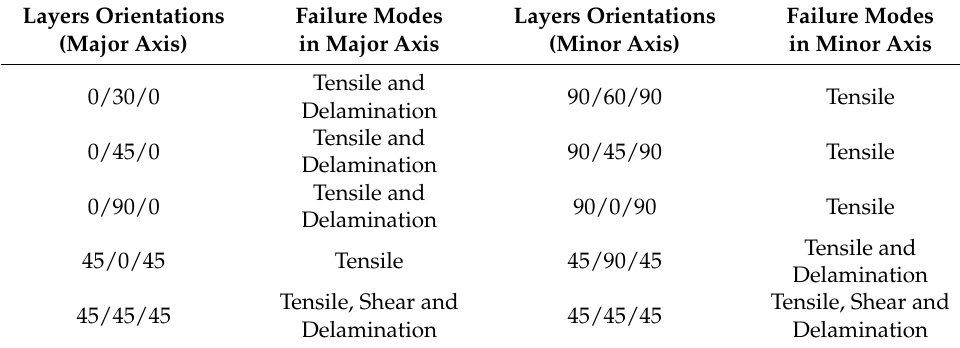
Figure 6. The types of failure modes of CLTs in the various arrangement ( a – d ) under out-of-plane bending test. Table 5. The types of failure modes of CLTs in various orientations.